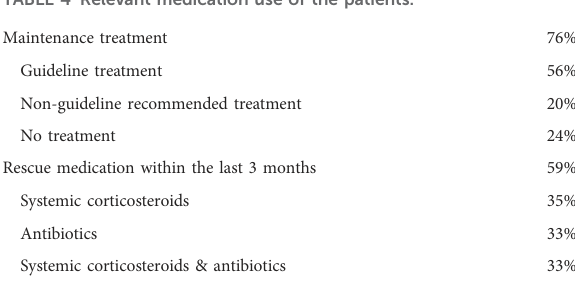
TABLE 4 Relevant medication use of the